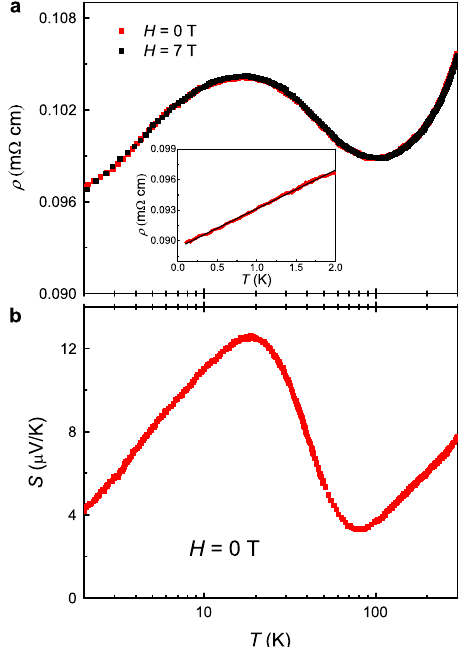
Fig. 2 Temperature dependence of the electrical resistivity and Seebeck coef fi cient. a Electrical resistivity ρ of CeCo 2 Ga 8 single crystal along the c -axis at zero fi eld and H = 7 T. The two sets of data are almost superimposable, showing small magnetoresistance. The inset plots the resistivity below 2 K measured in a dilution refrigerator, indicating linear-in- T (non-Fermi liquid) behavior over a decade in temperature from 2 K down to 0.1 K. No sign of superconductivity is observed down to 0.1 K. b Temperature dependence of the Seebeck coef fi cient at zero fi eld, showing similar behavior as in the